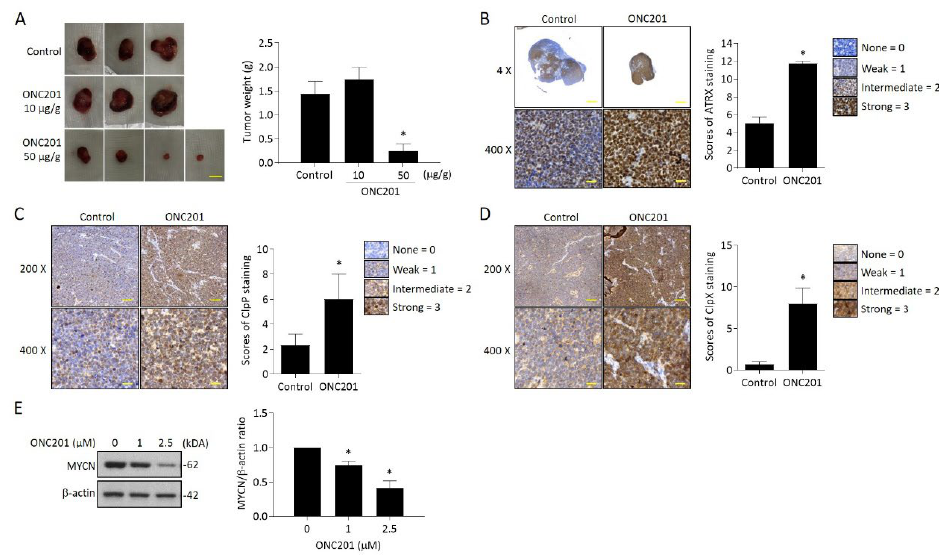
Figure 6. Effect of ONC201 administration on tumor growth in NB xenograft animal model and ClpXP and ATRX expression in tumor tissues: ( A ) Images of the resected tumors in the three groups. Tumor weight (g) was measured at sacrifice by microbalance and expressed as mean ± SD. Control = 3, treatment = 5. Scale bar 1 cm. ( B ) Representative pictures of ATRX expression in control and ONC201-treated neuroblastoma tissues. Scale bar 100 µ m ( upper panel ) and 30 µ m ( lower panel ), respectively. The percentage of nuclear ATRX-positive cells was calculated from five random images at 400x magnification per tissue, and are expressed as mean ± SD ( n = 3). ( C , D ) Immunohistochemistry analysis of ClpP and ClpX expression in controls and ONC201-treated neuroblastoma tissues. Scale bar 30 µ m. The intensities of ClpP and ClpX staining were calculated from five random images at 400 × magnification per tissue, and are expressed as mean ± SD ( n = 3). ( E ) Analysis of MYCN expression in ONC201-treated BE(2)M17 cells by Western blot. The relative protein ratio was normalized with β -actin using Image Pro-plus analysis software. * p <